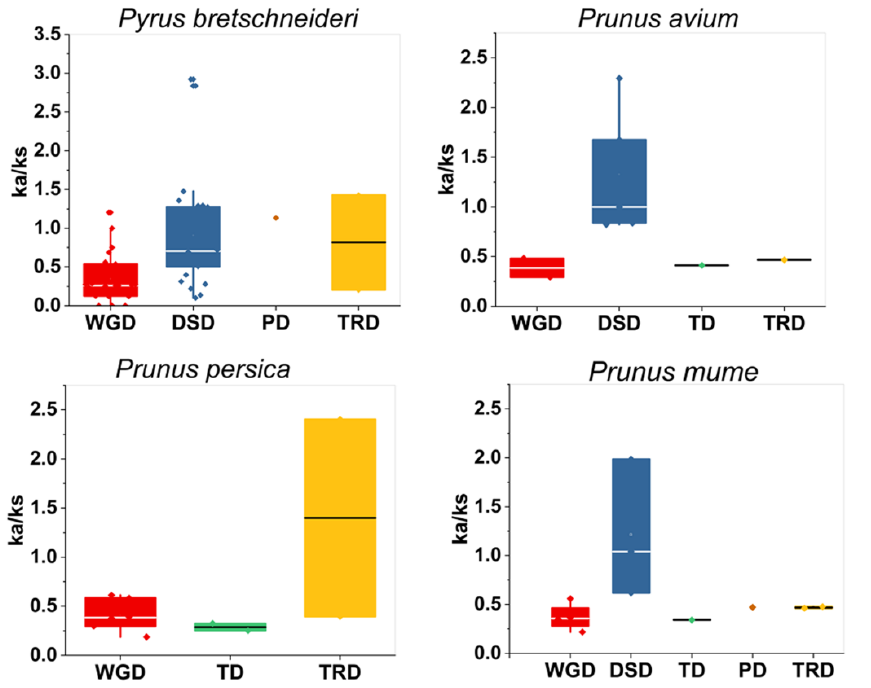
Figure 6. Ka/Ks values of GATA genes family in four Rosaceae species. Comparison of Ka/Ks values for different modes of gene duplications. DSD, dispersed duplicates; PD, proximal duplicates; WGD, whole-genome duplicates; TRD, transposed duplicates; TD, tandem duplicates.